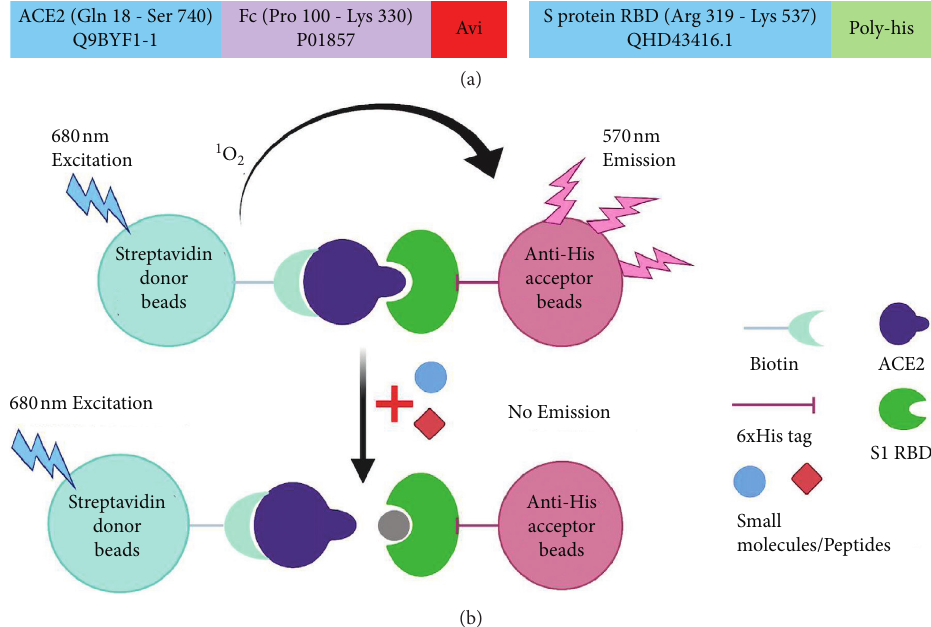
Figure 1: AlphaScreen ™ -based screening scheme. (a) Human ACE2 tagged with biotin and SARS-CoV-2 S1 RBD tagged with His6 were utilized. The boxes representing the proteins include the residue sequences and the NCBI accession codes. (b) Streptavidin (donor) and nickel chelate (acceptor) beads tether to ACE2 and S1 RBD, respectively. A laser applied at 680nM excites the donor beads to react with ambient O 2 , activating it to a singlet state ( 1 O 2 .) An interaction between the 2 proteins will bring the beads in close proximity ( < 200nm) and allow 1 O 2 to diffuse and pass on energy to the acceptor bead, causing emission and production of a measurable luminescence signal (570 nm). Small molecules or peptides that disrupt this binding interaction cause signal loss.